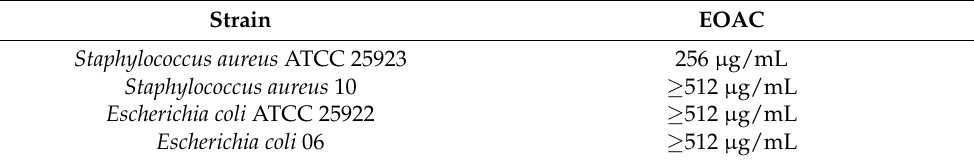
Table 3. Minimum inhibitory concentration of Acritopappus confertus essential oil against bacterial strains. Strain